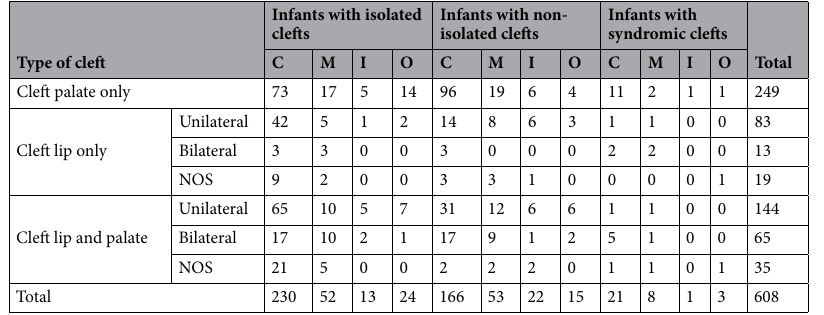
Infants with isolated clefts